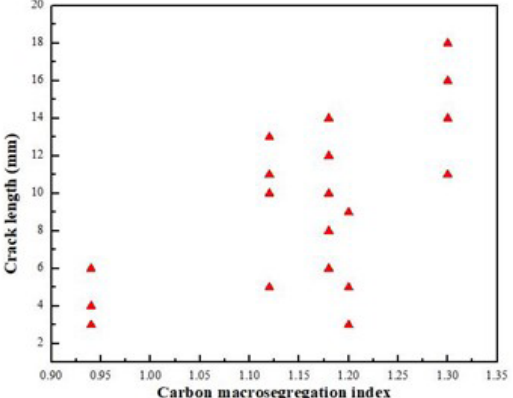
Figure 9. The relationship between carbon macrosegregation indexes and crack lengths.